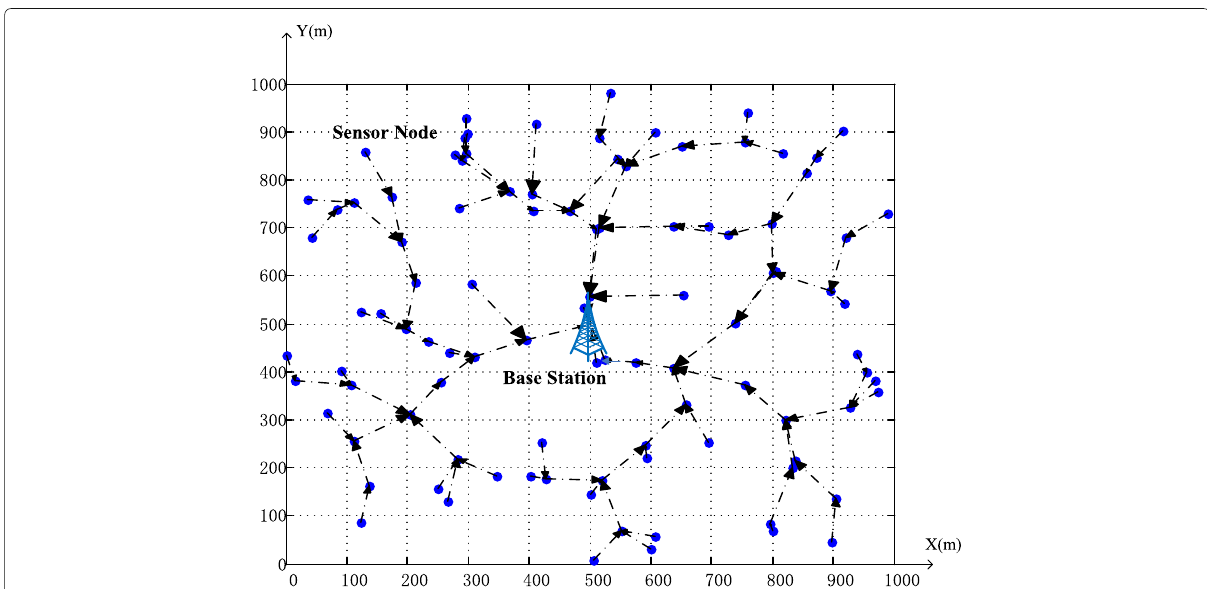
Fig. 7 The energy behavior of node i during the n th and ( n + 1)th charging period. T i (cid:3) is defined as the visiting and charging interval of i , which is the time interval between two adjacent arrivals at i by MCV. In ERSVC, the MCV only visits and charges a portion of nodes in each cycle, and the visiting set in each cycle is different. Therefore, the moment when MCV arrives at i is different every time, and the visiting interval T i (cid:3) is variable. In Fig. 7, a i is the moment when MCV arrives at node i in the ( n + 1)th charging period. After the time of t i , the MCV charges the battery of node i to E max . Apparently, the slope is ( U − p i ) when the MCV is charging node i and the slope is p i at other